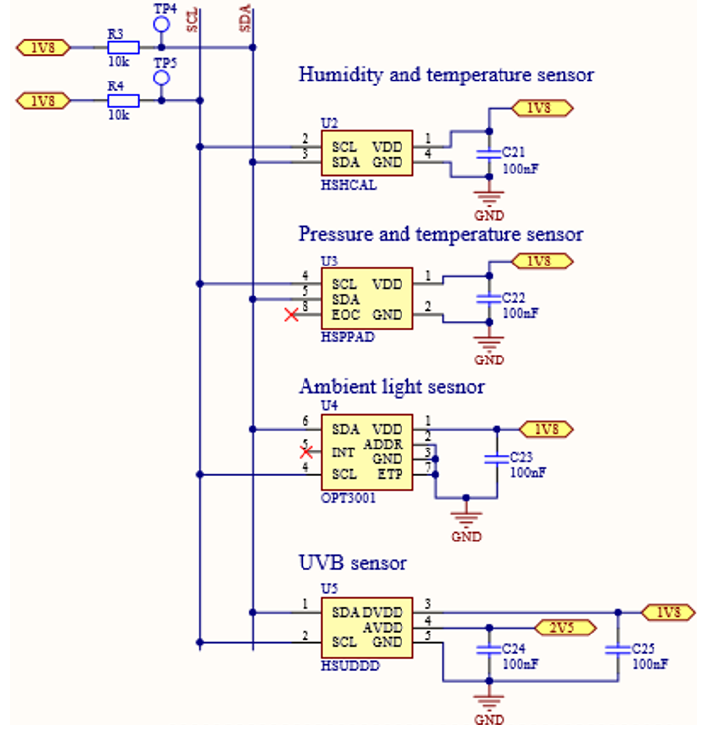
Figure 5. The I2C sensors